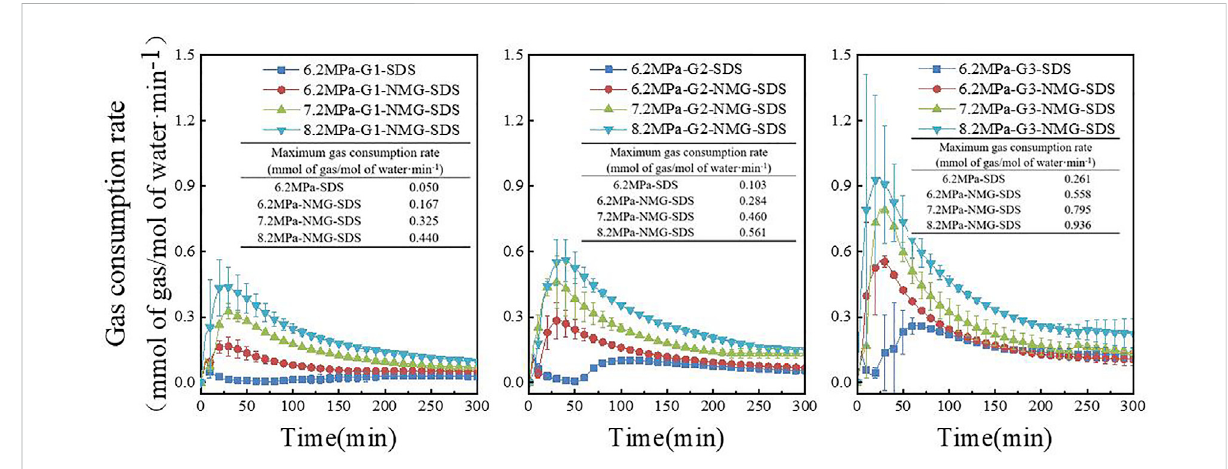
FIGURE 7 Gas consumption rate during gas hydration of different gas components under different systems.